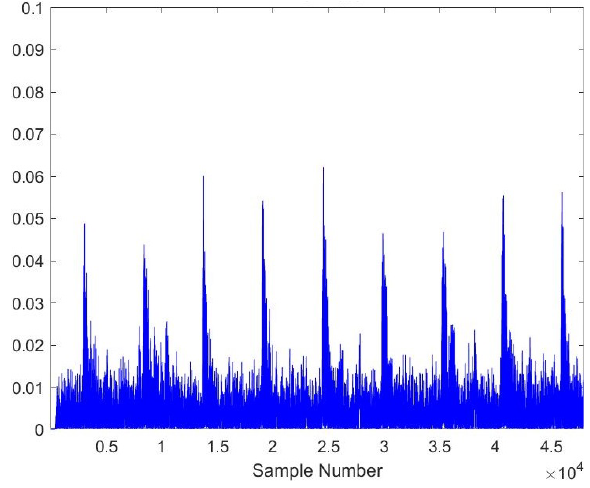
Figure 5. RMS plot of Hardwood, Average Tool, 3 mm depth-of-cut.